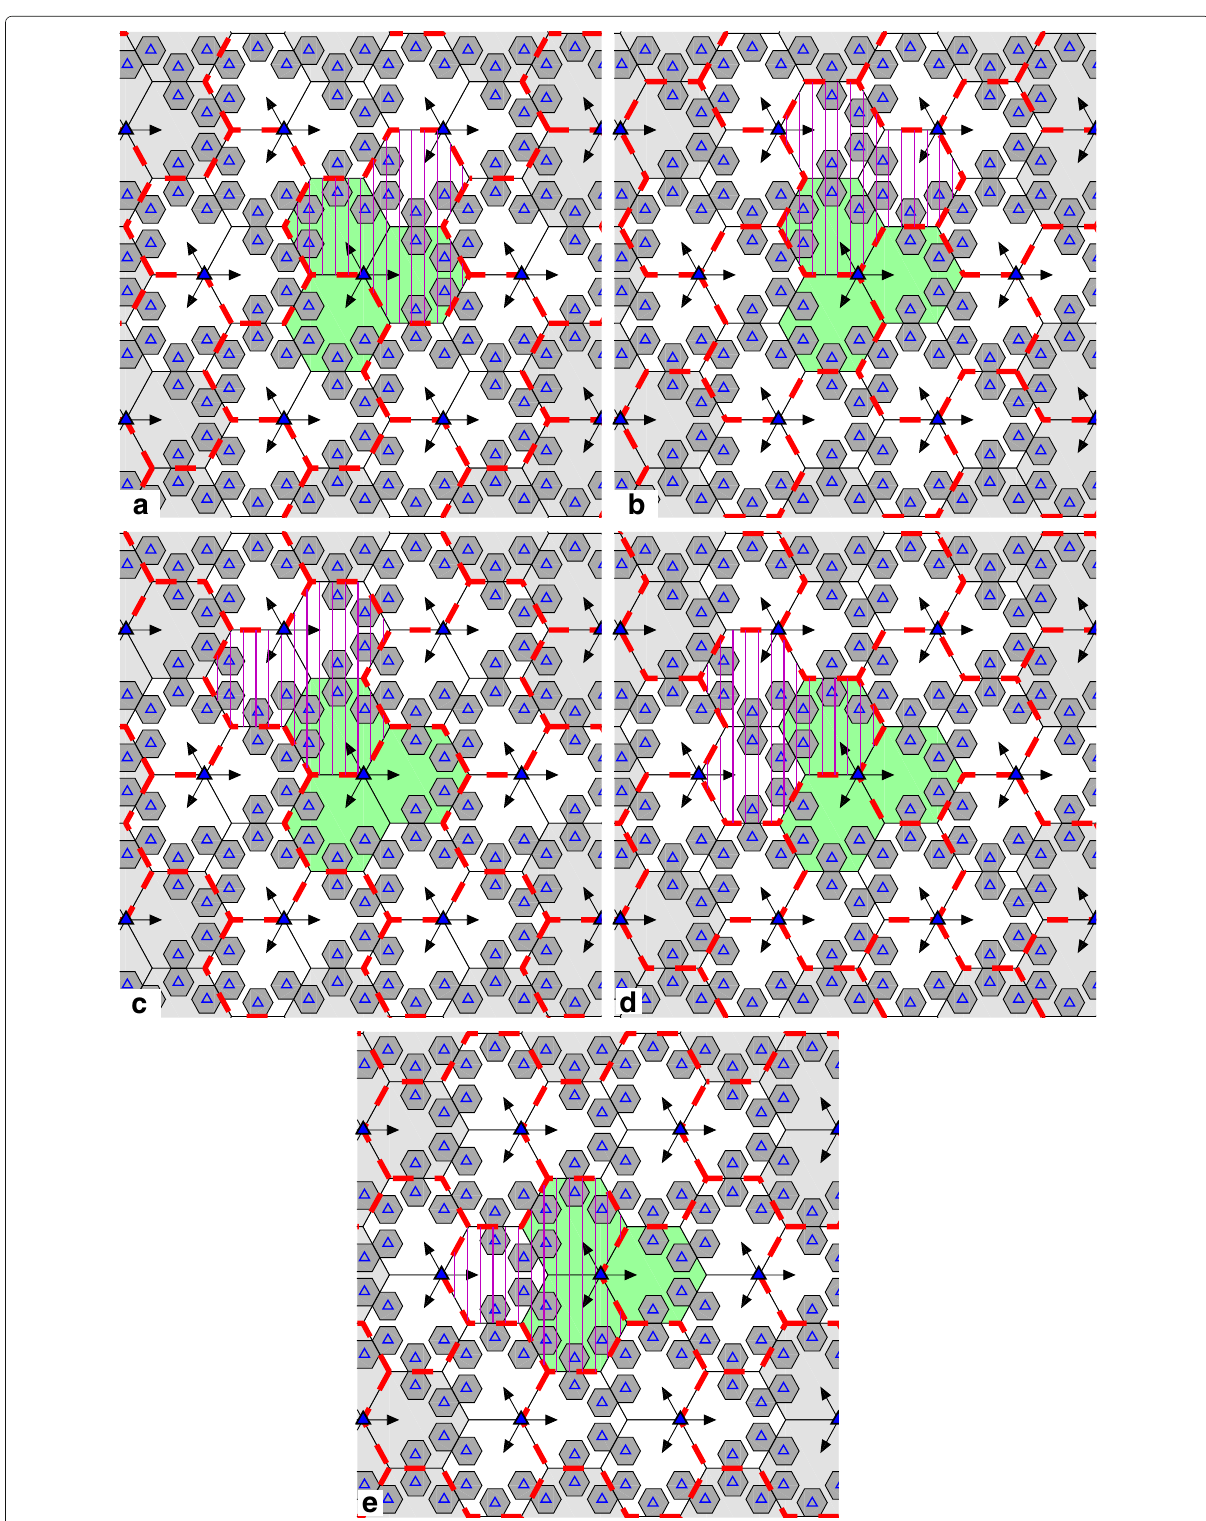
Fig. 2 Network layout with three cells per macro site for HetNet with cluster rotation: a – e depict five different clustering patterns of BS coordination. Solid and open triangles represent macro BS sites and pico BSs, respectively, and thick red dashed lines denote cluster